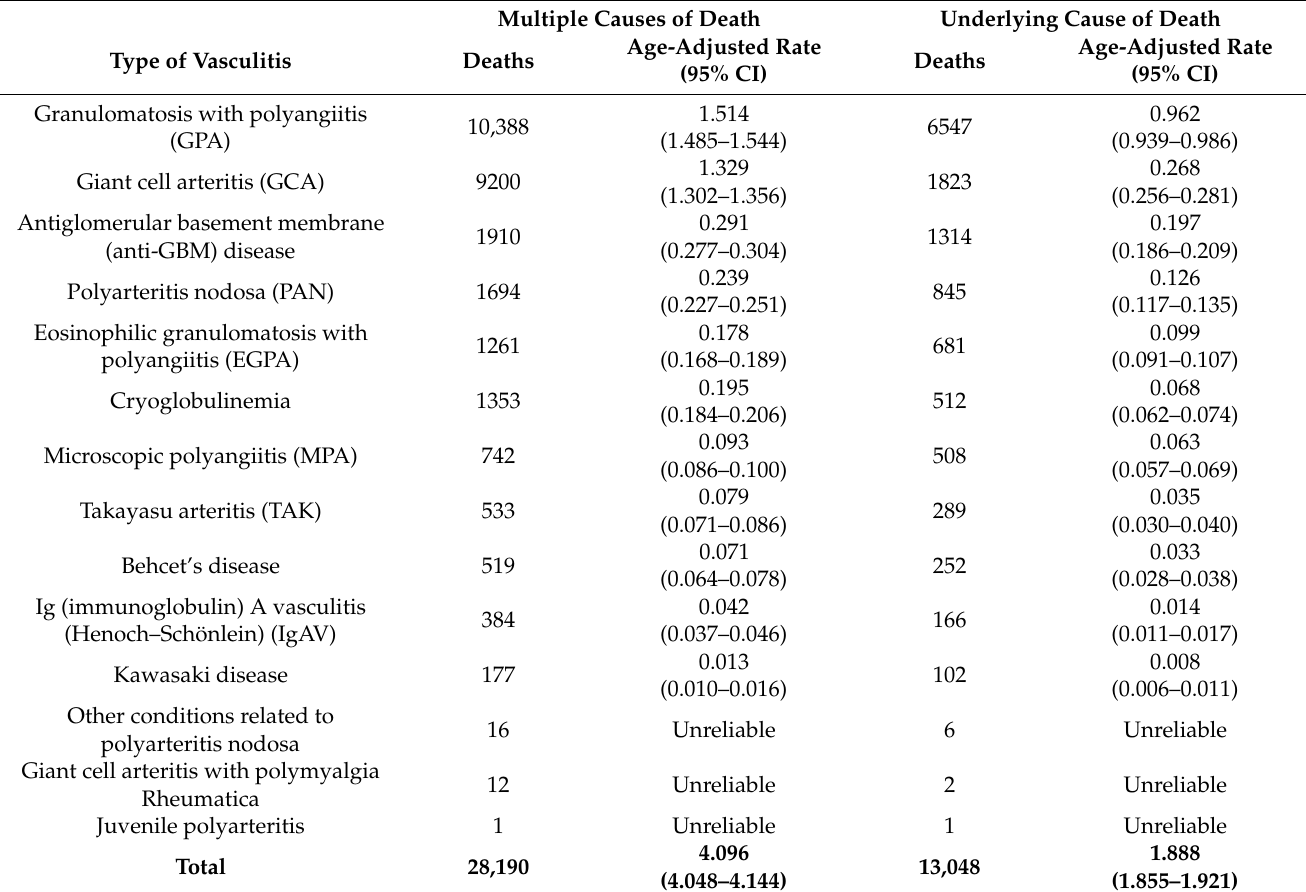
Table 2. Age-adjusted mortality rates per million, by the specific type of vasculitis (1999–2019), presented in descending order by underlying cause of death.